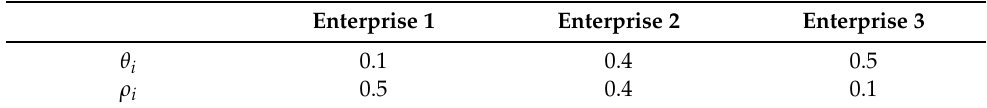
Table 4. Assumed θ i and ρ i of three enterprises.